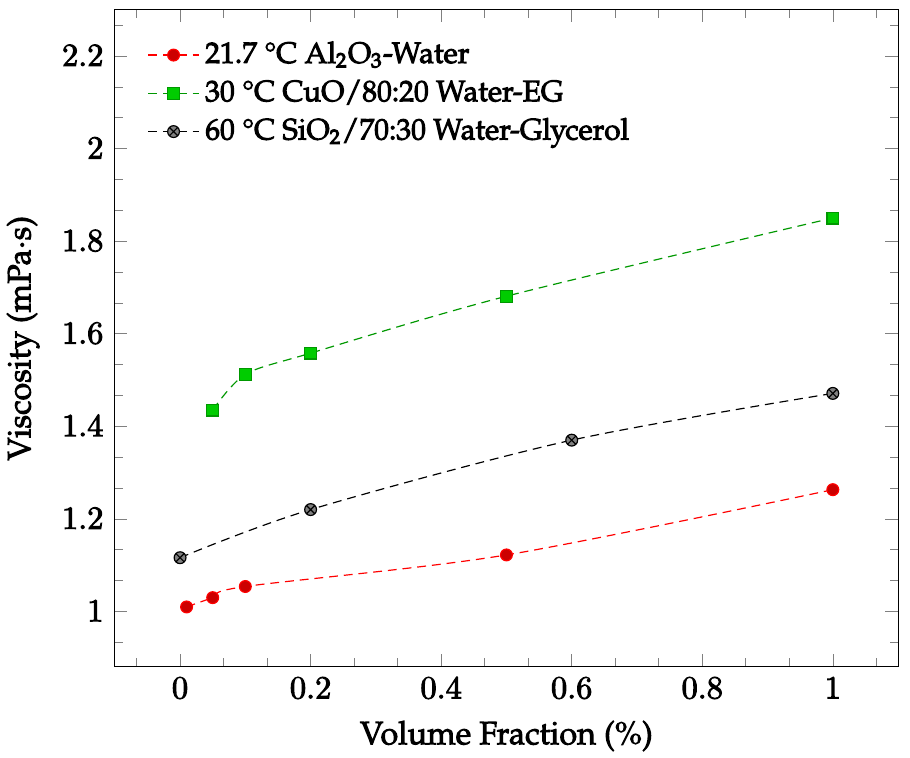
Figure 3. Nanofluid viscosity as a function of concentration for various nanofluids, including Al 2 O 3 in water at 21.7 °C [30], CuO in 80:20 water-ethylene glycol (EG)at 30 °C [31], and SiO 2 in 70:30 water-glycerol at 60 °C [32].